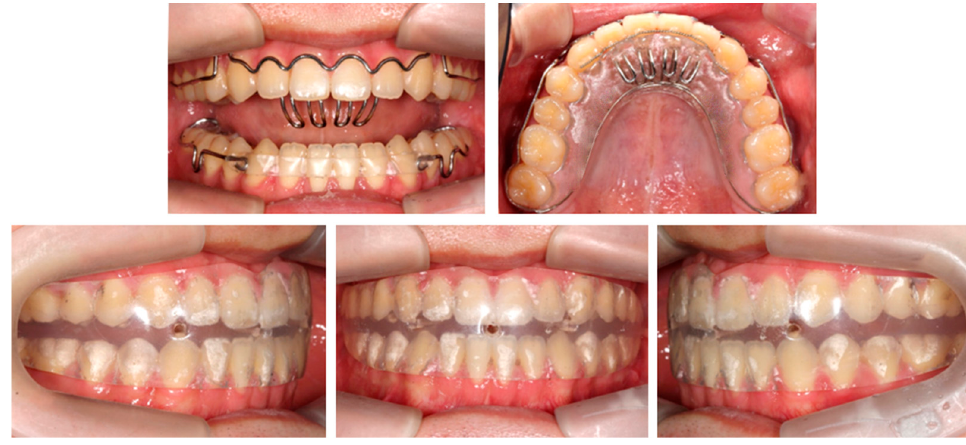
Figure 8. Retainers. Top , wraparound-type retainers; Bottom , tooth positioner.